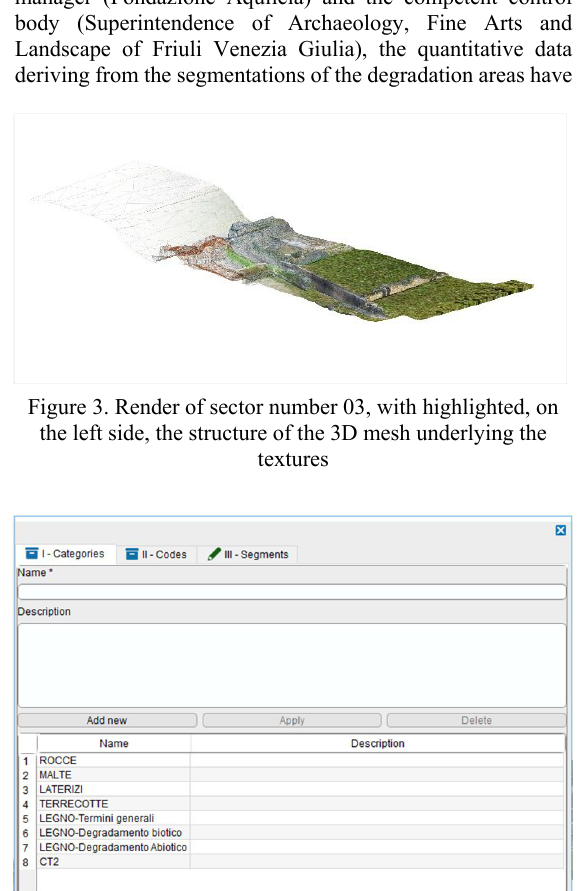
Figure 4. EasyCUBE PRO user interface for inserting/modifying segmentation categories